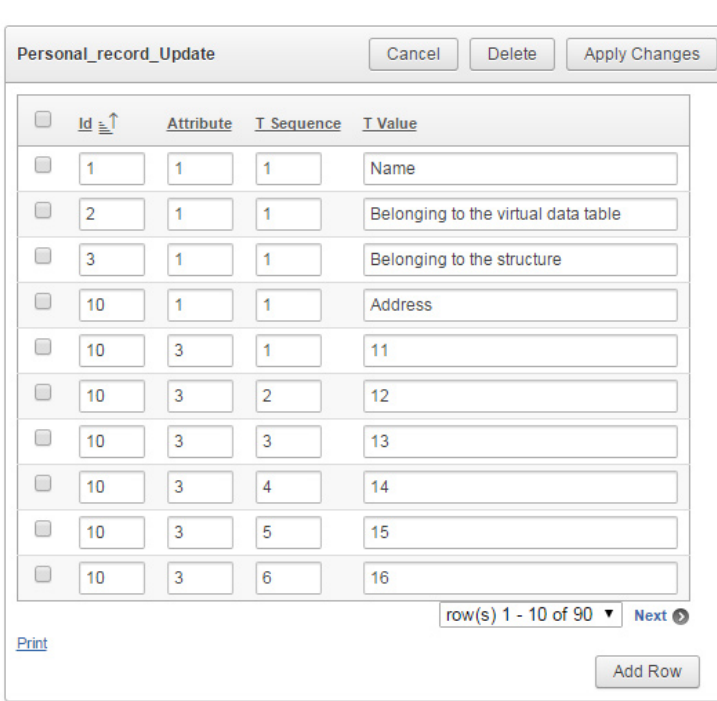
Figure 3. Entity